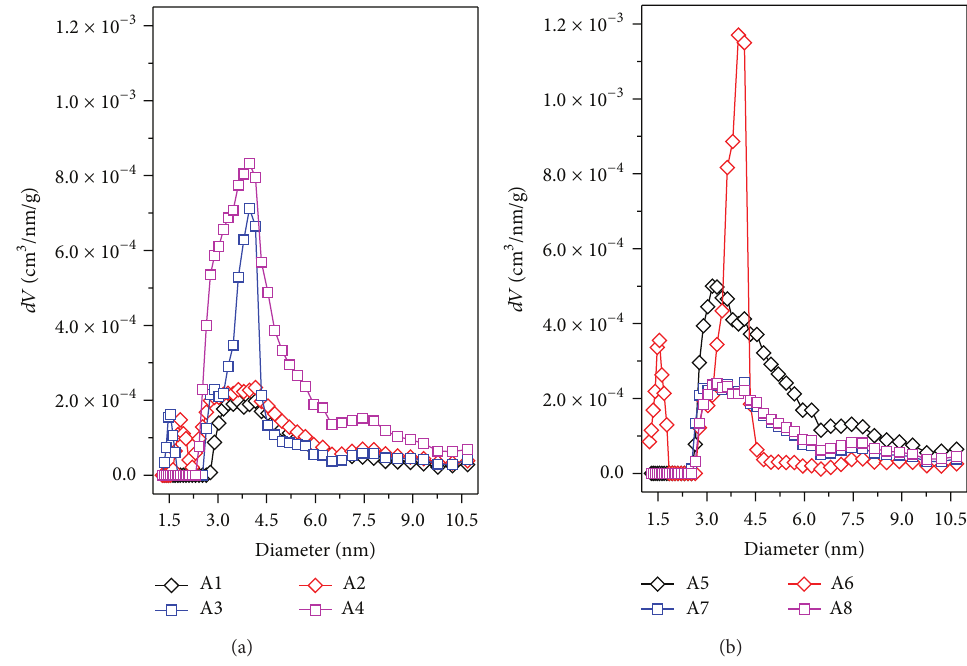
Figure 3: Pore size distributions obtained by applying the DFT